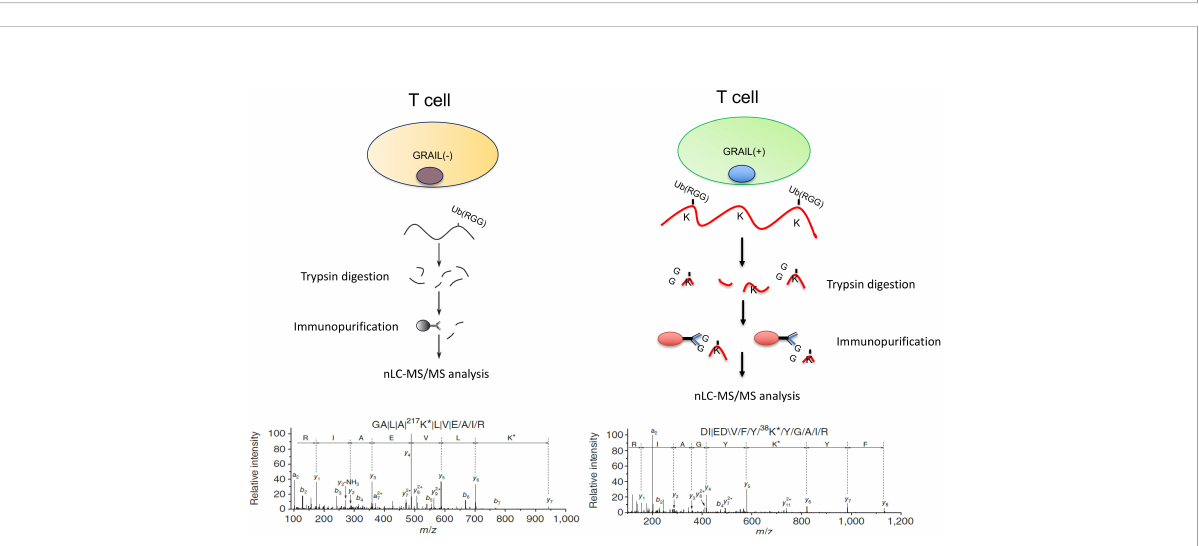
FIGURE 4 Proteins ubiquitinated by GRAIL. We identi fi ed proteins ubiquitinated by GRAIL using a new E3 target identi fi cation system from Cell Signaling Technologies. A monoclonal antibody recognizes the di-glycine tag on ubiquitinated lysines on proteins that can then be identi fi ed by differential mass spectrometry and sequencing. GRAIL mono-ubiquitinates lysine 724 on Cul5. This is the exact lysine that must be neddylated to allow the Cul5 ring ligase to function. Thus, GRAIL acts as a competitive inhibitor of neddylation to inhibit IL-2R desensitization in